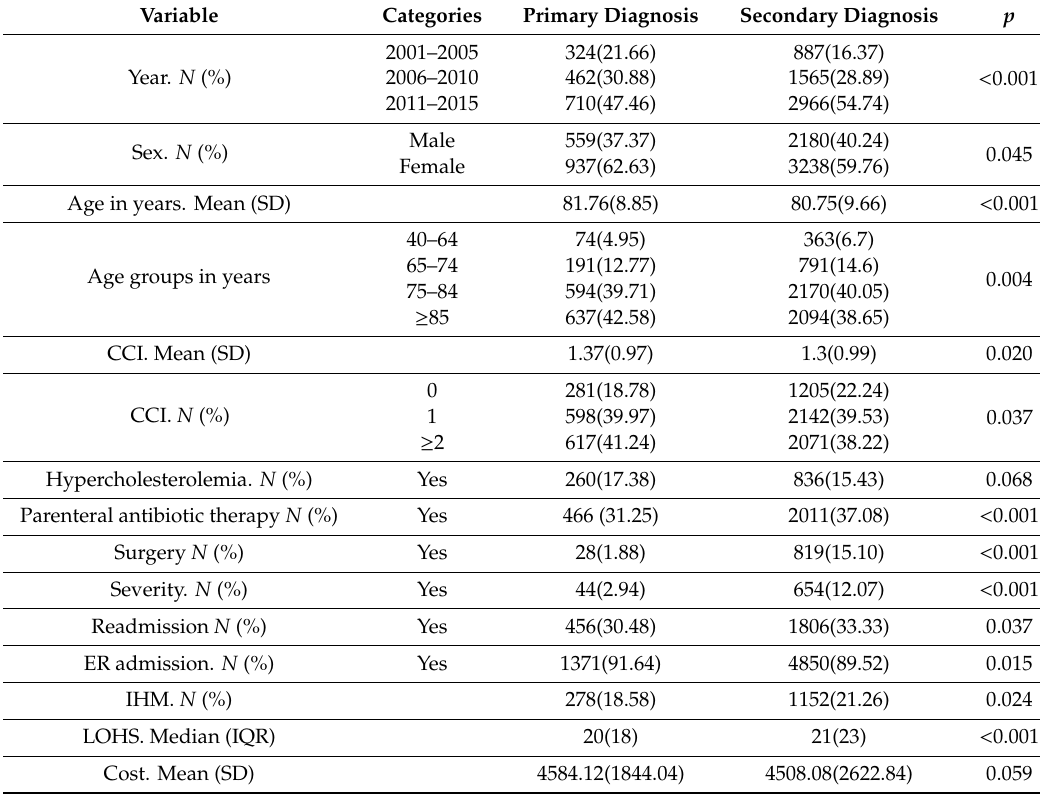
Table 2. Characteristics of hospital admissions of patients with primary diagnosis and patients with secondary diagnosis of Clostridioides di ffi cile infection among patients su ff ering heart failure in Spain, from 2001 to